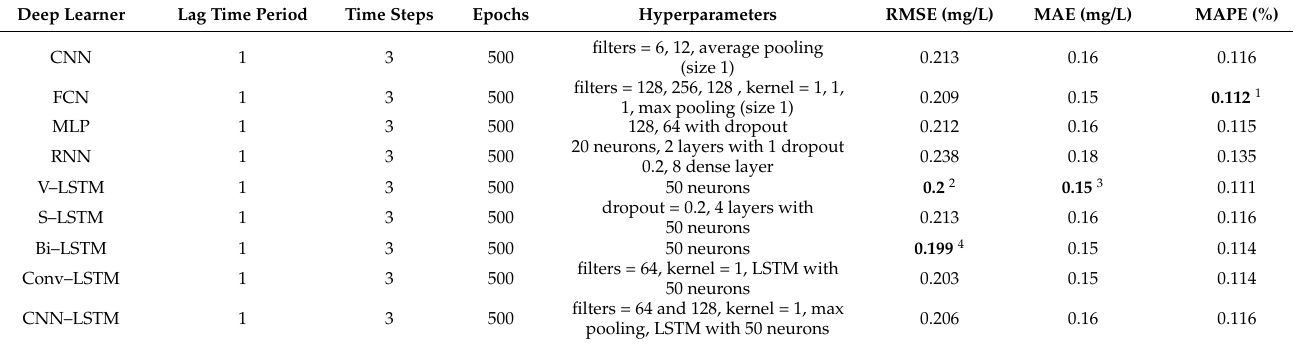
Figure 7. Results for the optically inactive parameter DO for the current (t) event. Table 4. Results for the optically inactive parameter DO for the multi–step (t + 1, t + 2, t + 3)